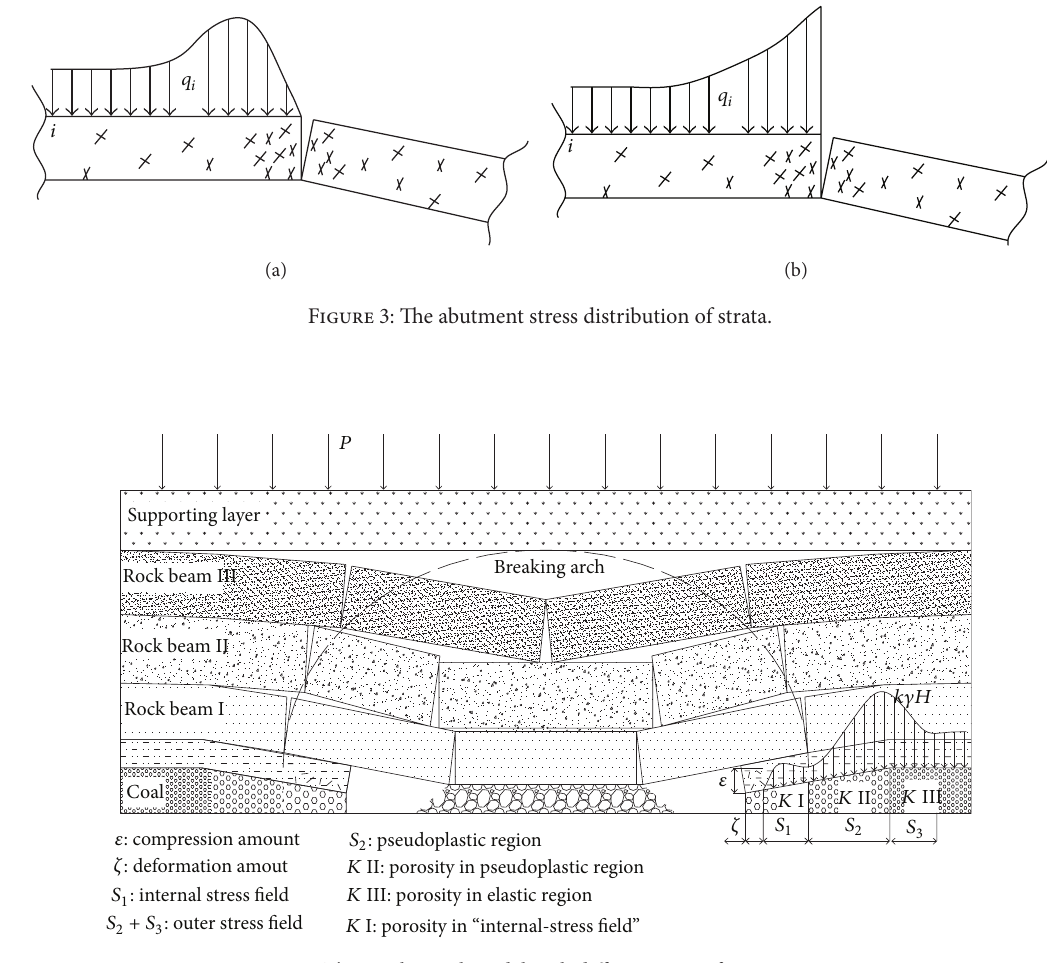
Figure 4: The mechanical model with different time of mining